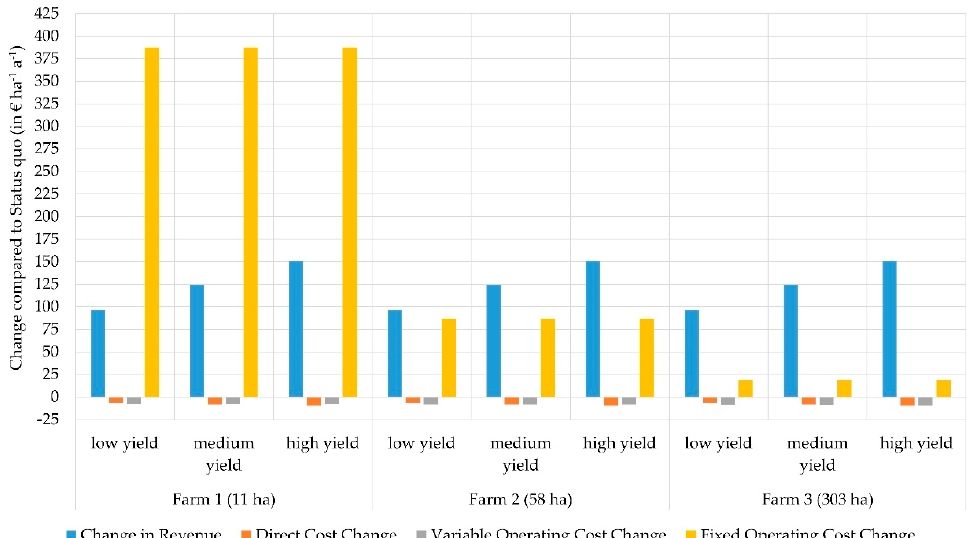
Figure 2. Farm economic changes of the status quo by using a yield-enhancing technology on Farms 1–3 with three different yield levels each (low, medium, high).